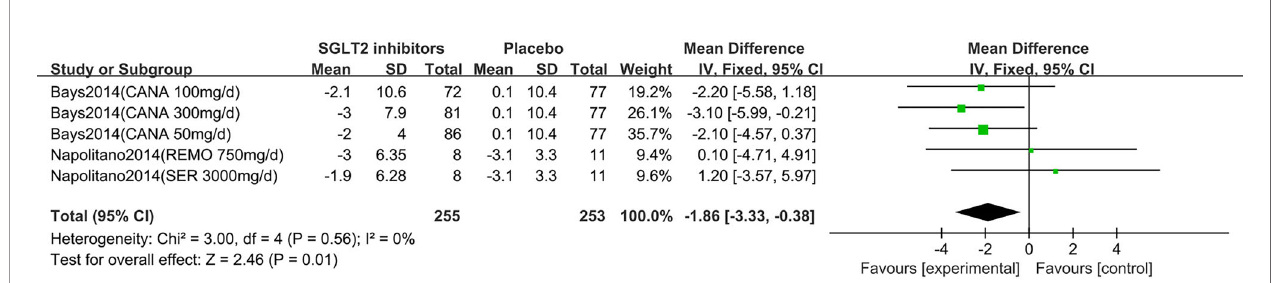
FIGURE 7 | Changes of hip circumference in patients receiving SGLT2 inhibitors versus placebo. CI, con fi dence interval; IV, inverse variance; SD,